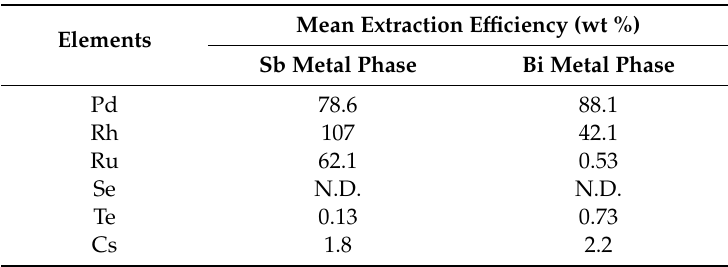
Table 3. The extraction e ffi ciency of the elements in di ff erent liquid metal